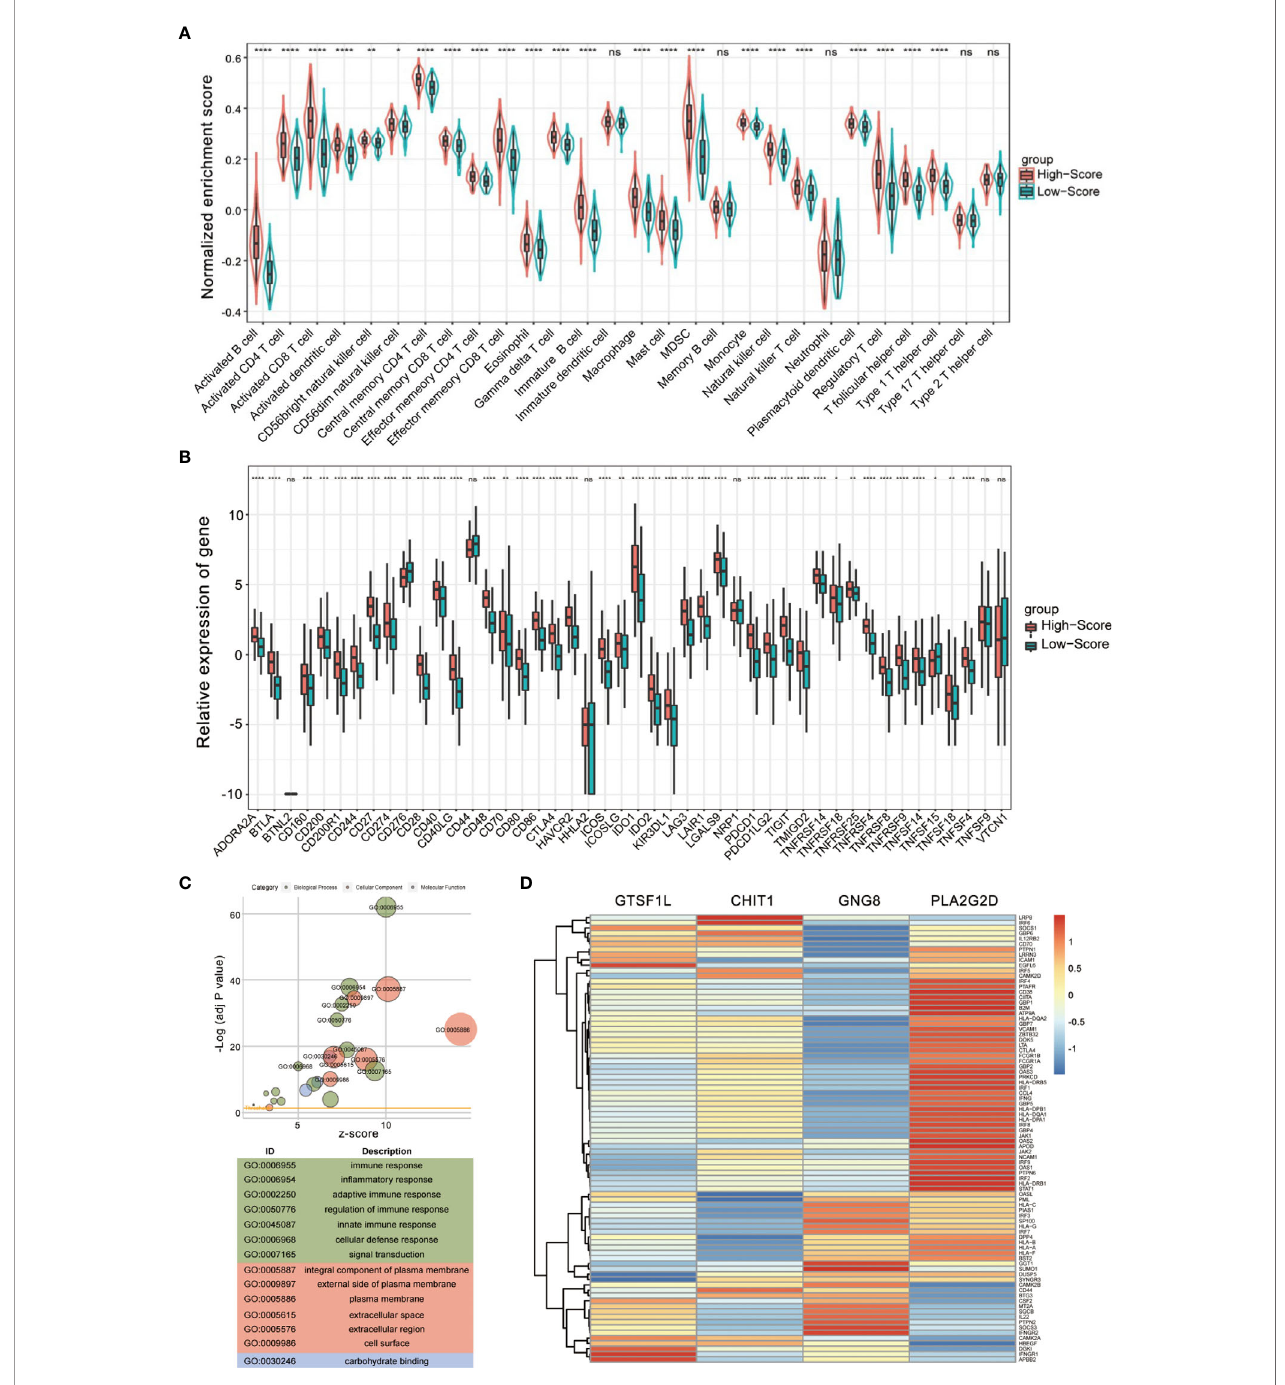
FIGURE 7 | Evaluation of tumor-in fi ltrating landscape and immune checkpoint inhibitor-related molecules by the Immunoscore. (A) Patients in the high-score group were more positively associated with tumor-in fi ltrating immune cells including CD4 + T cells, CD8 + T cells, and T follicular helper cells. The statistical difference of two groups was compared through the Wilcoxon test. * p < 0.05; ** p < 0.01; *** p < 0.001; **** p < 0.0001, ns, not signi fi cant. (B) High Immunoscore was positively associated with increased immune checkpoint levels such as PDCD1, CTLA4, and LAG3 in patients with CESC. The statistical difference of two groups was compared through the Wilcoxon test. * p < 0.05; ** p < 0.01; *** p < 0.001; **** p < 0.0001, ns, not signi fi cant. (C) Gene Ontology (GO) enrichment analysis of the differentially expressed genes between high- and low-score groups. (D) A heatmap showing the correlation between the four immune-related genes and Th1/IFN g